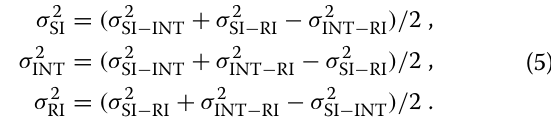
UTC formal errors of the corresponding − UTC differences of the full network solution HtHbYg −